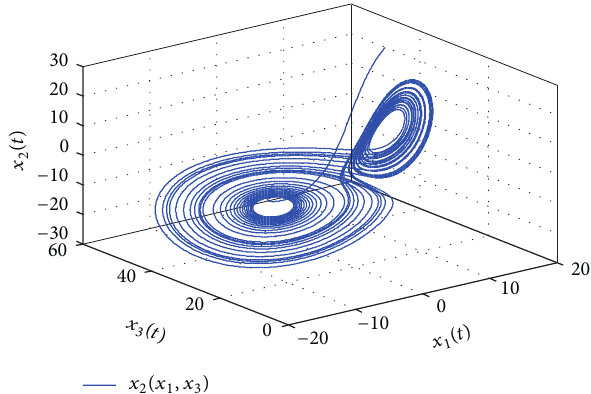
Figure 1: Chaotic behavior of Lorenz fuzzy system.